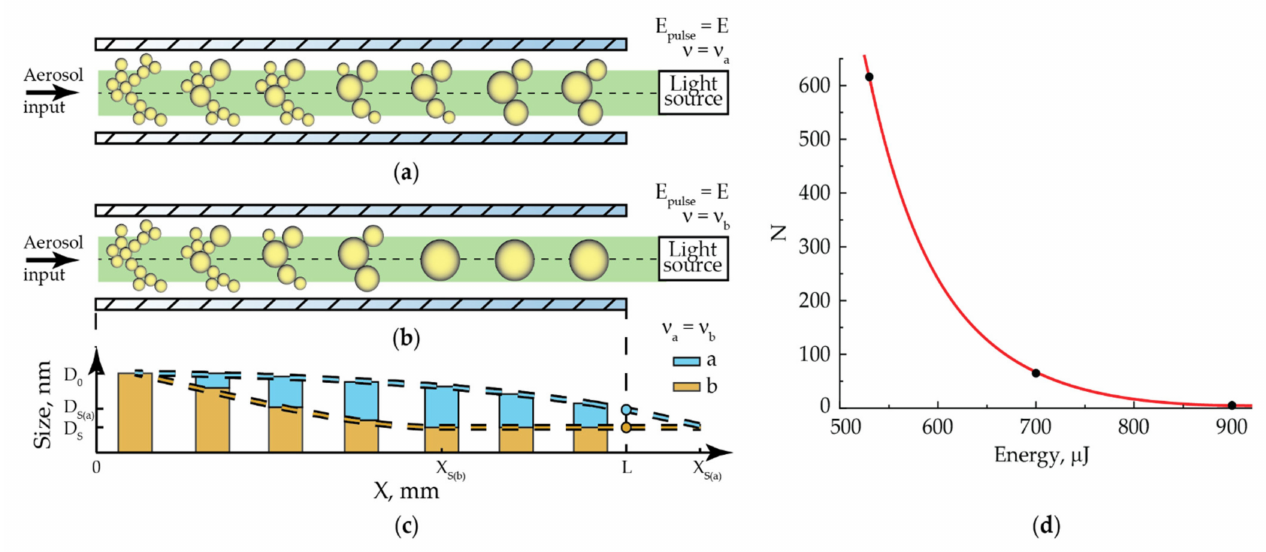
Figure 10. Illustrations of the NPs modification processes in the cell by laser radiation with different repetition rates ( a ) ν a and ( b ) ν b and the equal pulse energies E and ( c ) the corresponding qualitative graph, representing the NPs size along the cell; ( d ) an estimated graph of required number of pulses for complete sintering of NPs for the working length of 145.2 mm on energy of laser pulses for radiation with the wavelength of 1053